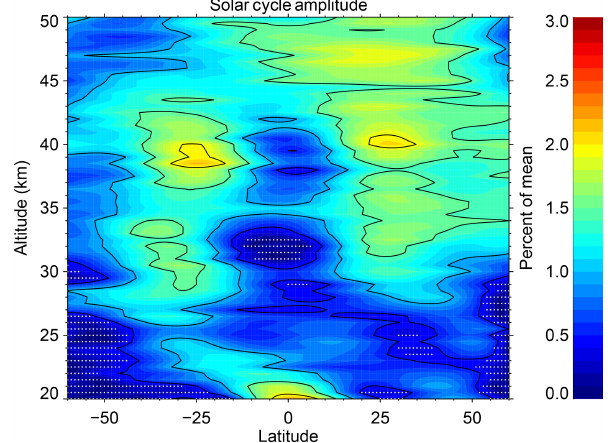
Figure 5. Amplitude of oscillation of the solar cycle response as a percentage of the local mean. Stippling denotes areas where the values are not significant at the 2 σ level. Contour lines are plotted at intervals of